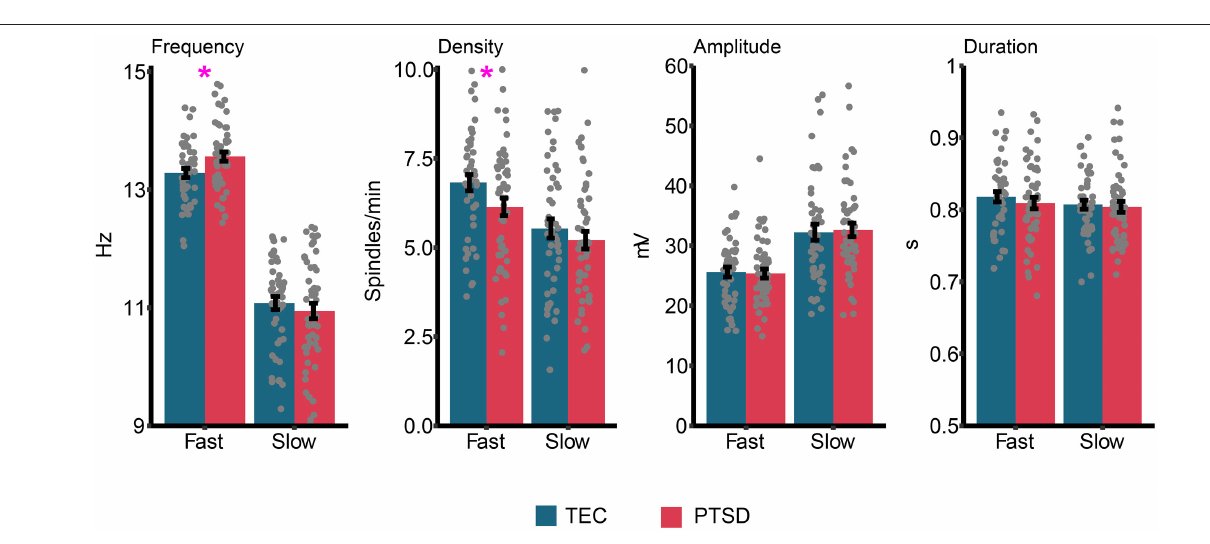
frequency, decreased depression, anxiety and stress, and better ability to regulate emotions. Interestingly, we also observed fewer,